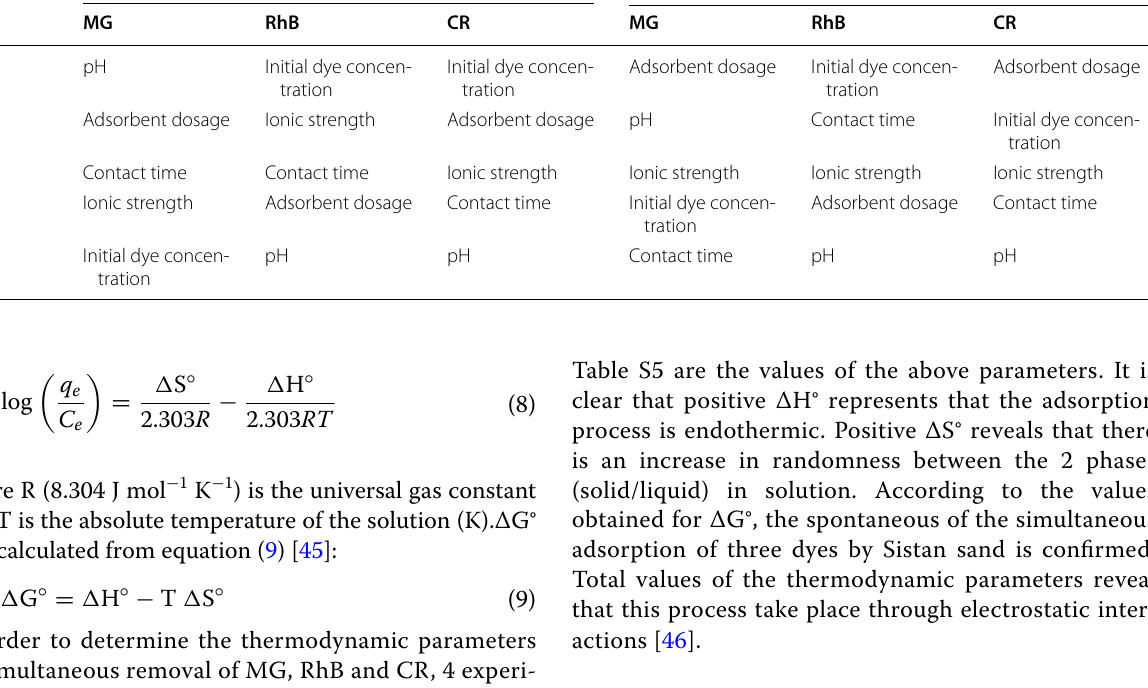
Table 5 The effectiveness of factors in PBD and Taguchi design Effectiveness Plackett-Burman